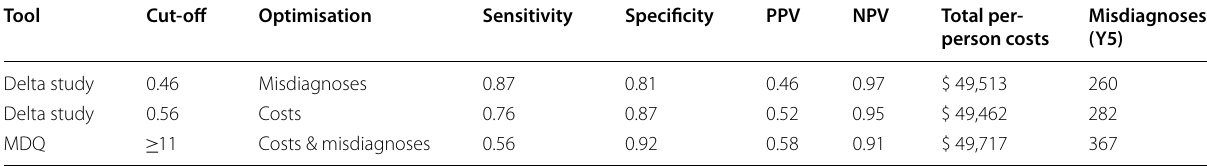
PPV: Positive predictive value; NPV: Negative predictive value; Y5: Year 5 of followup; MDQ: Mood disorder questionnaire